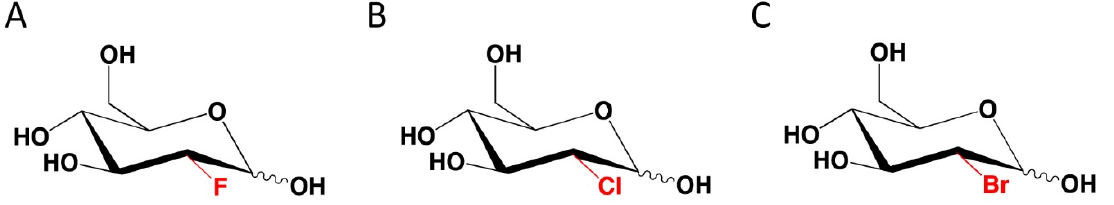
Figure 3. Structures of ( A ). 2-deoxy-2-fluoro-D-glucose (2-FG), ( B ). 2-deoxy-2-chloro-D-glucose (2-CG), and ( C ). 2-deoxy-2-bromo-D-glucose (2-BG).